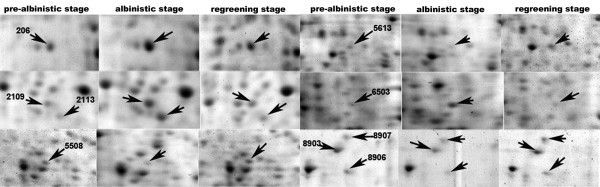
Enlarged view of the expression patterns of few spots at three developmental stages.